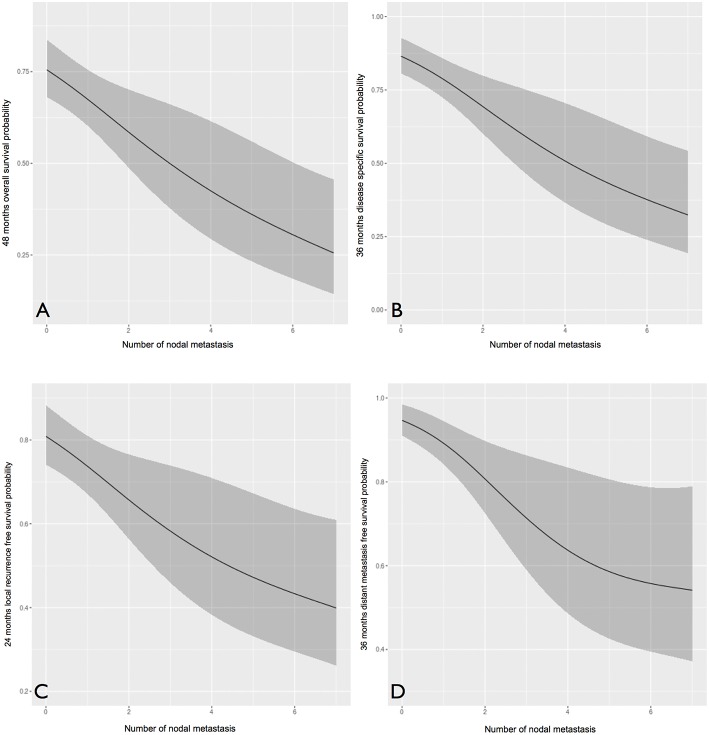
The influence of number of positive nodes (analyzed as a continuous variable) on overall (A), disease-specific (B), local recurrence-free (C), and distant metastasis-free (D) survival probability. In all cases, an inverse proportion relationship is evident.